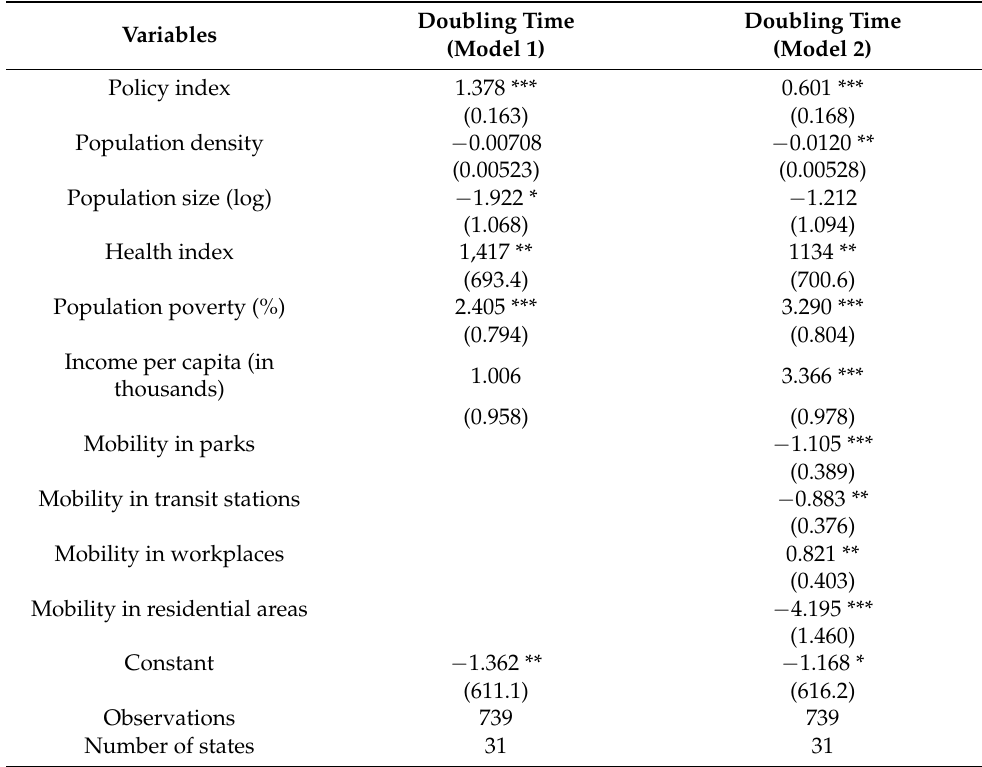
Table 3. Panel data model: Effect of variables of interest on doubling time in Mexican